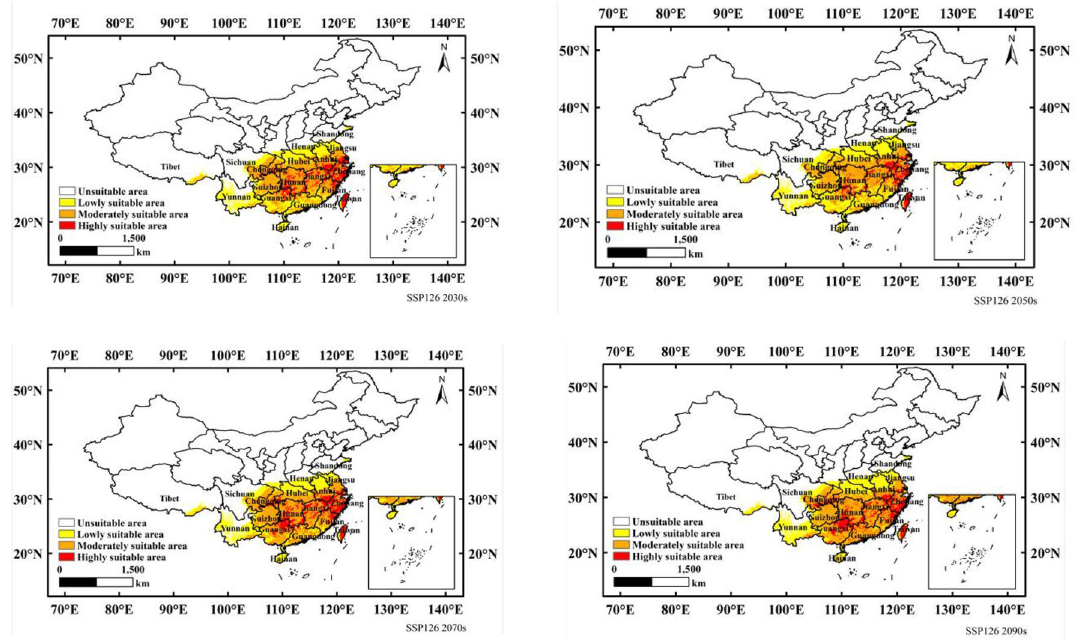
Figure 5. Potential suitable distribution of N. californicus in China based on MaxEnt under scenario of SSP126. Created in ESRI ArcMap 10.8.1 (https:// suppo rt. esri. com/ en/ Produ cts/ Deskt op/ arcgis- deskt op/ arcmap).